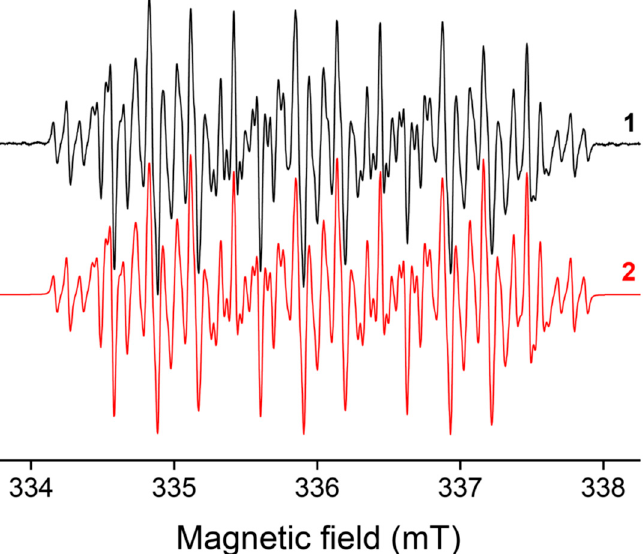
Figure 5. The experimental (1) and simulated (2) EPR spectra of the 4-methylphenyl radical spin adduct of ND produced upon photoexcitation of allylated purpurin and an iodonium salt in benzene. Reproduced from Ref. [35]. Copyright 2021 permission Royal Society of Chemistry.